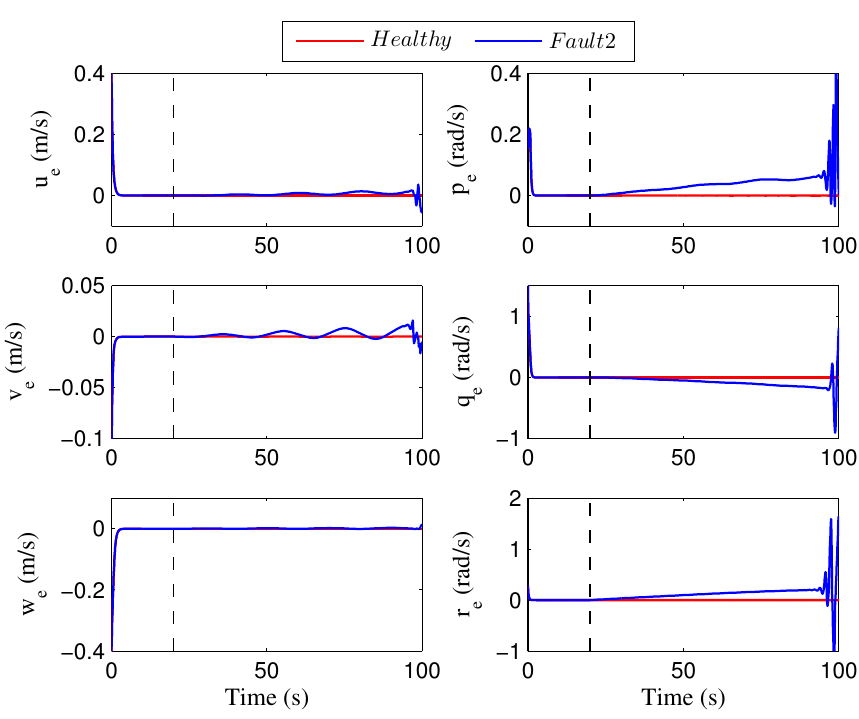
Figure 10. The velocity and angular velocity errors with fault